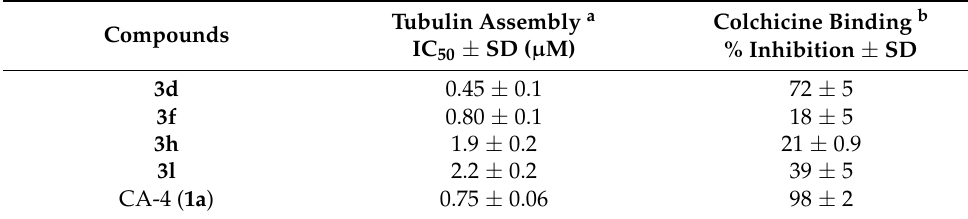
Table 2. Inhibition of tubulin polymerization and colchicine binding by compounds 3d , 3f , 3h , 3l and CA-4 ( 1a ).